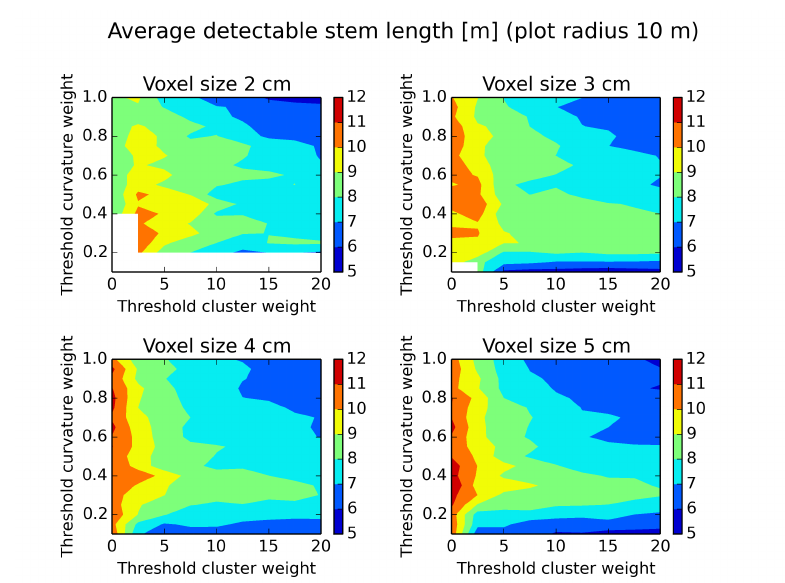
Figure 12. Average detectable stem length evaluated on a plot of a radius of 10 m and different parameter settings. White areas indicate missing data. Low threshold parameter values give many estimated stem diameters along the tree.